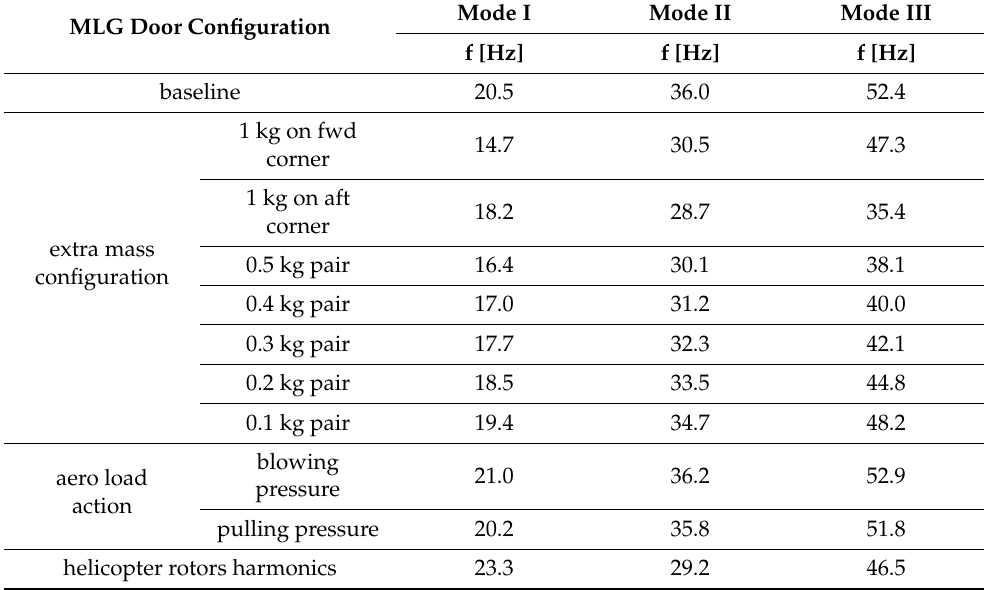
Table 5. Matrix of nominal cases with deployed door: natural frequencies